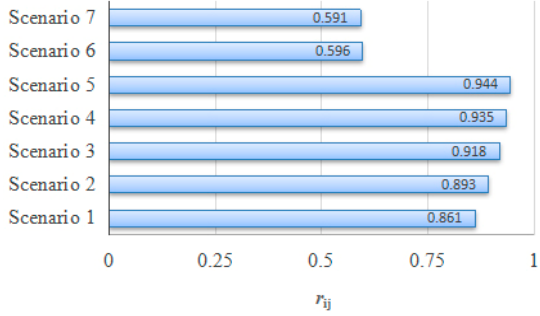
Figure 5. Integrated weight information.